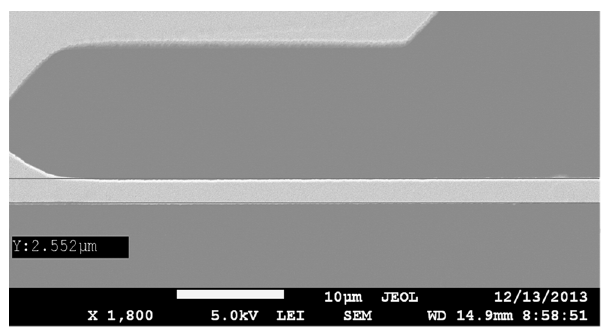
Figure 6. SEM micrograph showing the measured anchor width.